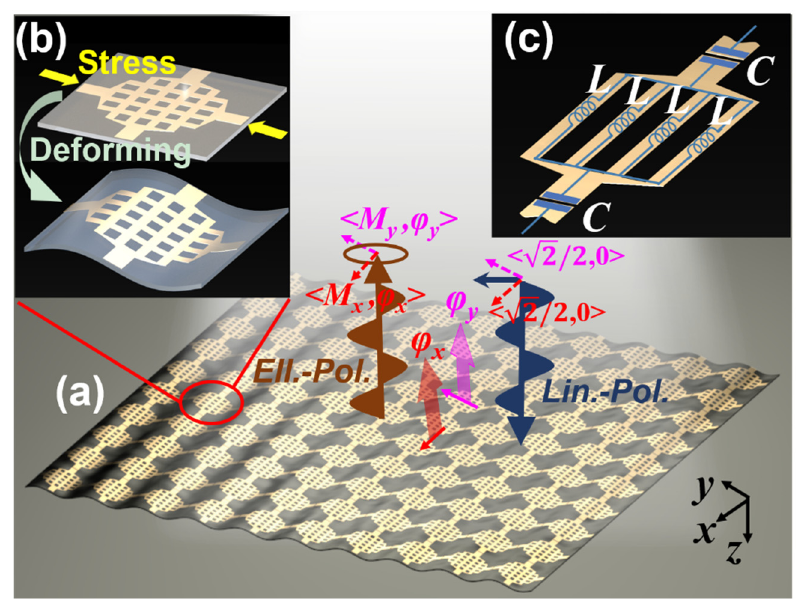
Figure 2. ( a ) Schematic of the wrinkled MS consisting of periodically arranged lantern-shaped elements shown in ( b ). Circuit model analysis is proposed in ( c ).